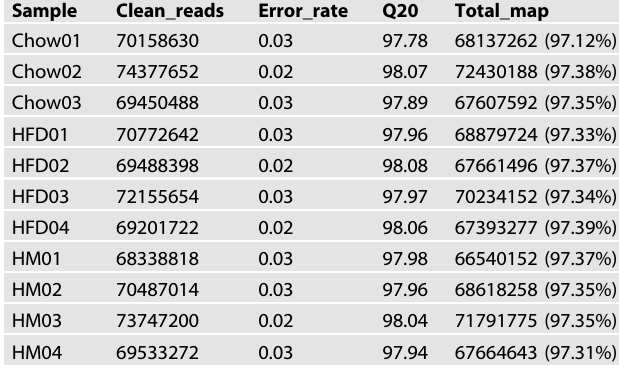
Table 1. Basic information of the sequenced sample